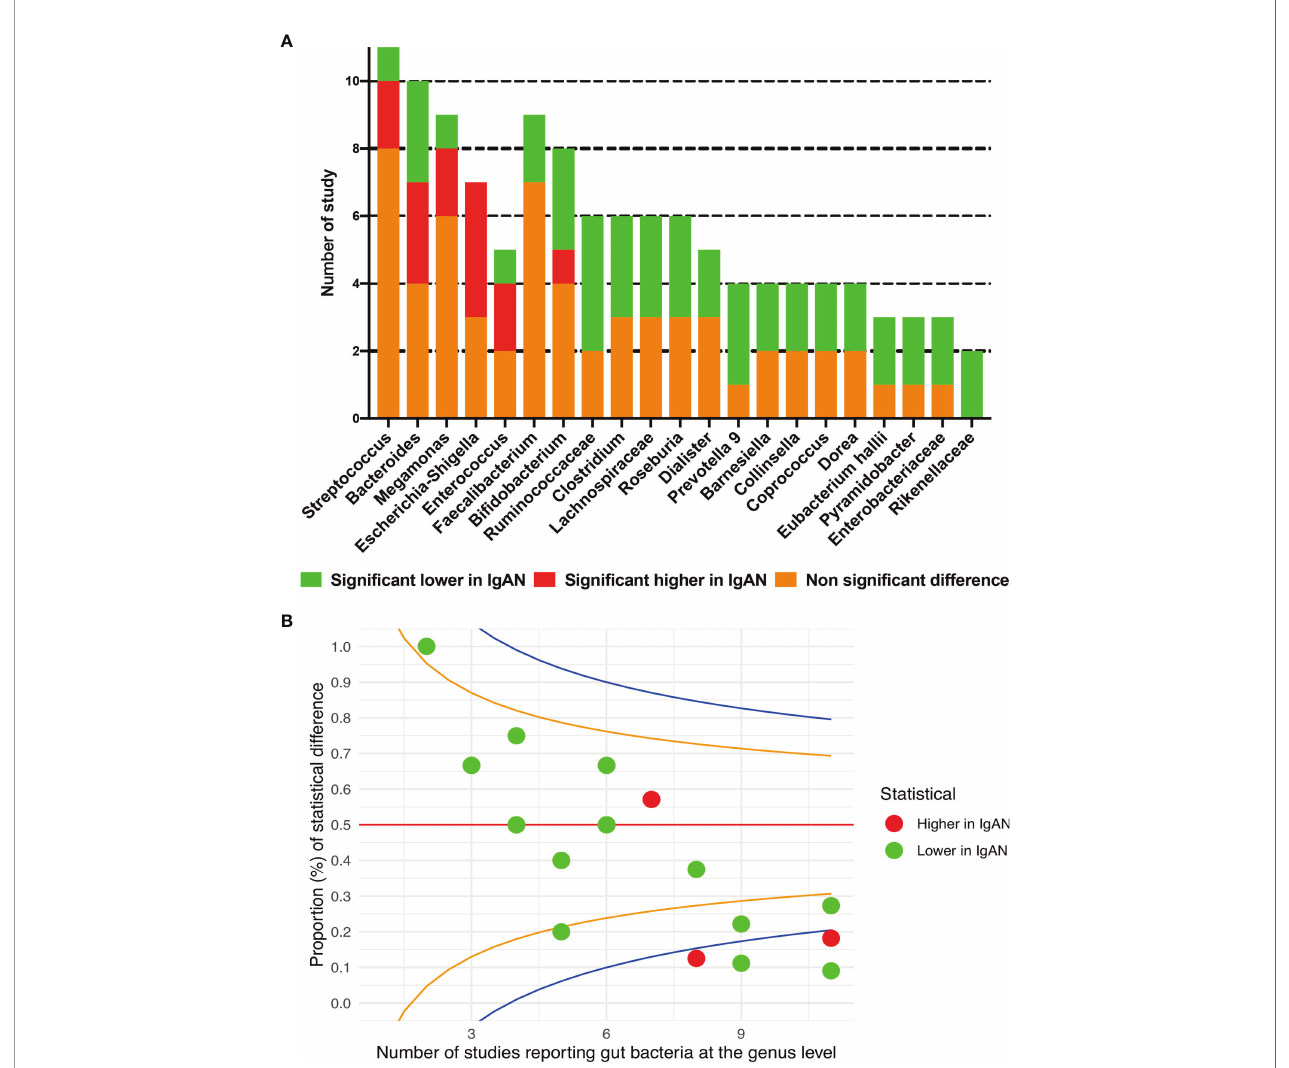
FIGURE 4 | Gut microbial composition between IgAN and healthy control at the genus level. (A) qualitative description; (B) the funnel plot, speci fi ed score2 con fi dence limits are showed at 50% (red line), 80% (orange line) and 95% (blue